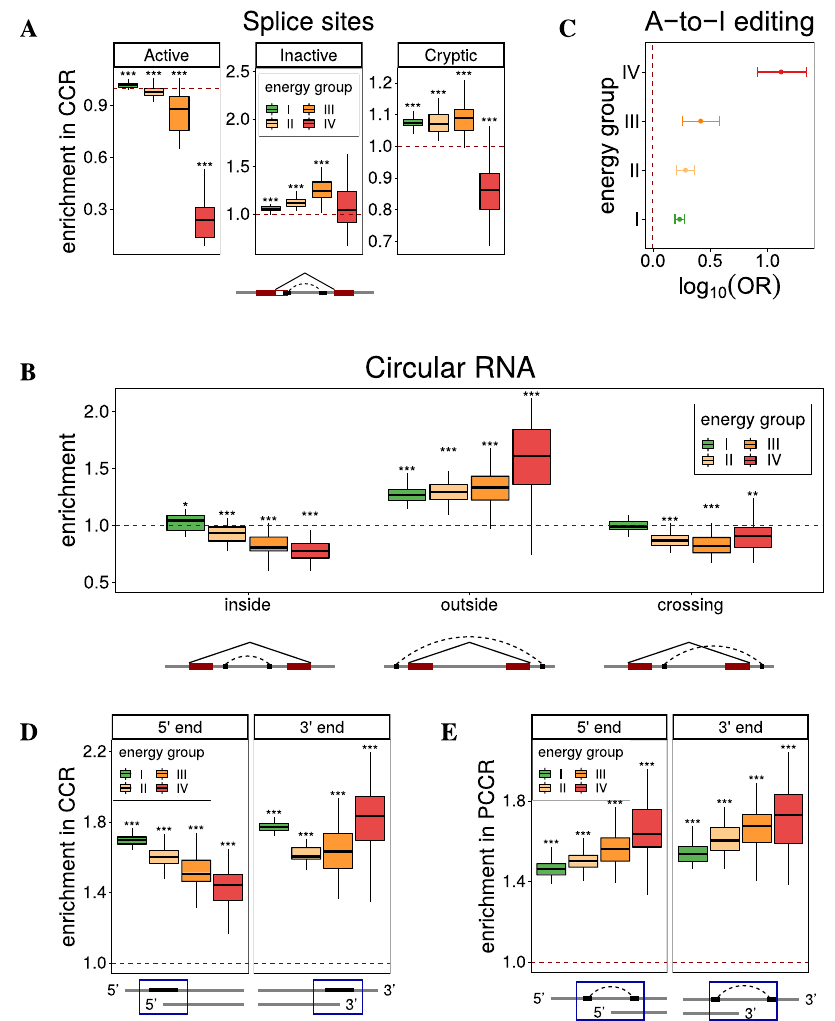
Fig. 4 Splicing, RNA editing, and end processing. A CCRs are depleted around actively expressed splice sites and enriched around inactive and cryptic splice sites. B PCCRs are enriched outside back-spliced introns (circular RNAs from TCSD, ref. 47 ) and depleted in inside and crossing con fi gurations. C CCRs are enriched with A-to-I RNA-editing sites (RADAR REDIportal 53,54 ); OR denotes the odds ratio (see “ Methods ” ); error bars represent the 95% con fi dence intervals. D CCRs are enriched with 5 ′ and 3 ′ ends of transcripts annotated in GENCODE database (including all aberrant and incomplete transcripts). That is, transcript ends frequently occur in double-stranded parts of PCCRs. E PCCRs are also strongly enriched with 5 ′ and 3 ′ ends of transcripts, that is, the annotated transcript ends frequently occur in the loop between double-stranded parts of PCCRs. In all panels, boxplots (represented by the median, upper and lower quartiles, upper and lower fences; outliers are not shown) correspond to n = 40 randomizations; *, **, and *** denote a statistically discernible difference at the 5%, 1%, and 0.1% signi fi cance level, respectively, for a two-tailed Wilcoxon ’ s test with H 0 : enrichment =